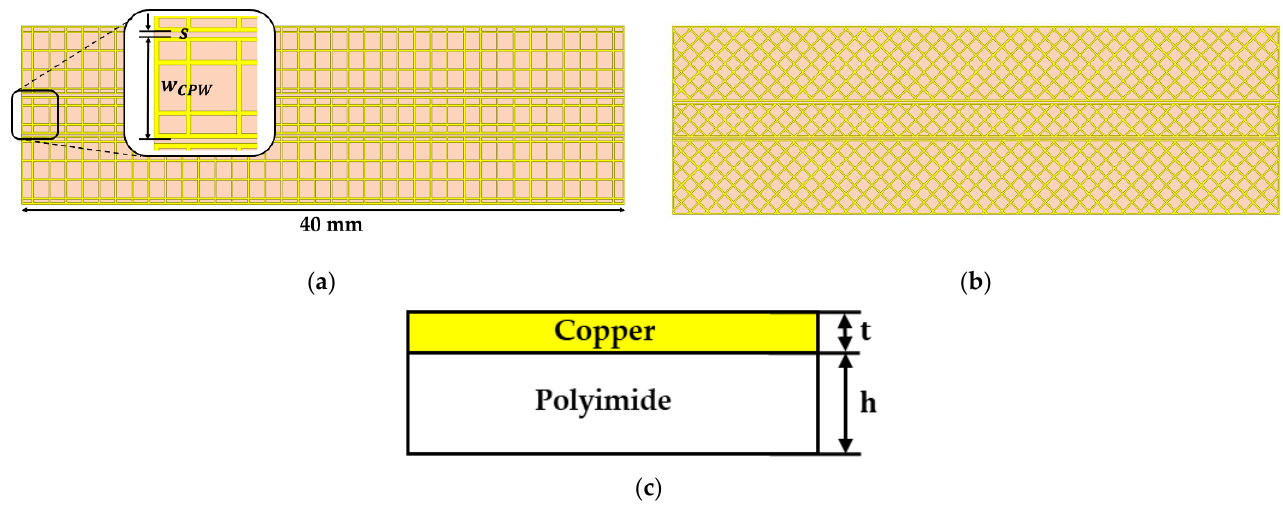
Figure 3. Meshed CPW configuration: ( a ) square-meshed CPW; ( b ) diamond-meshed CPW; ( c ) side view of meshed line.